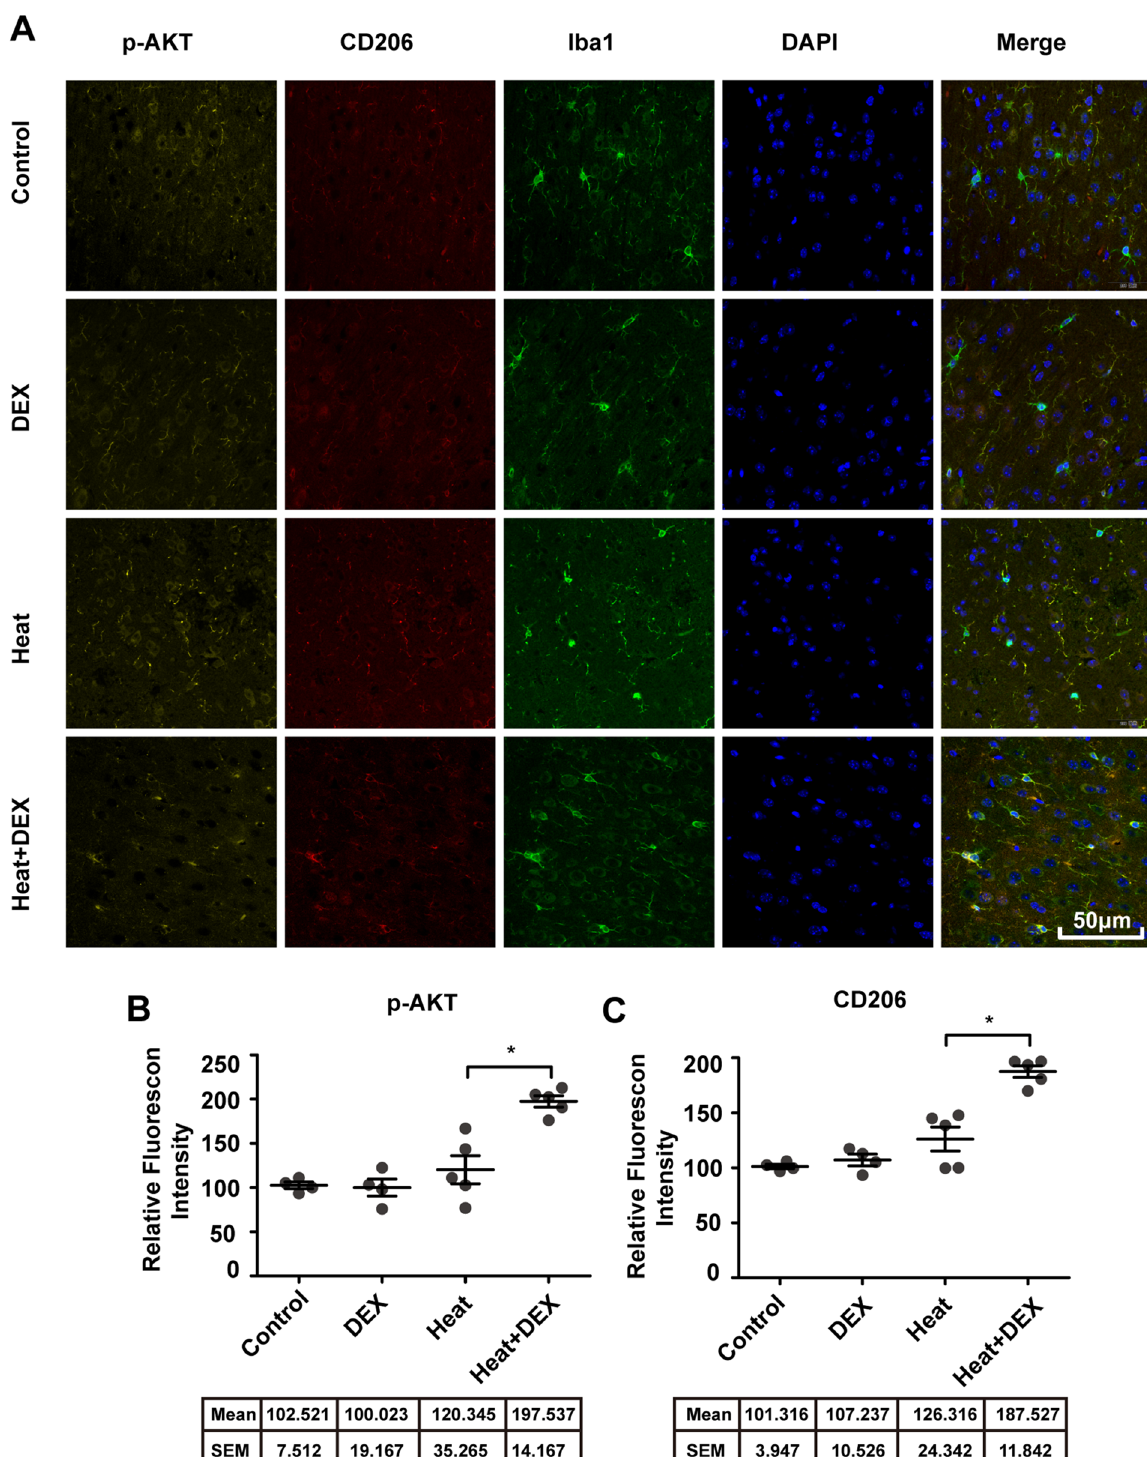
Figure 5. The PI3K/AKT signalling pathway is involved in the DEX-mediated transition to the neuro- protective type in the cerebral cortex of heatstroke mice. ICR mice were exposed to an ambient temperature of 41 ± 0.5 °C until Tc > 42.7 °C (heatstroke onset), and then injected intraperitoneally with 25 µg/kg DEX (heat + DEX group) or 0.9% saline (heat group), followed by a 12-h recovery at an ambient temperature of 23 ± 1 °C. ( A ) The expression of p-Akt in the cerebral cortex was visualized by immunofluorescence using CD206 and Iba1 co-labelling at a magnification of X-400. ( B , C ) Bar graphs show the semi-quantification of the relative fluorescence intensity of p-Akt and CD206 in microglia. The data are shown as the mean ± SEM of three independent experiments. Statistical analysis: Two-way ANOVA. * p <